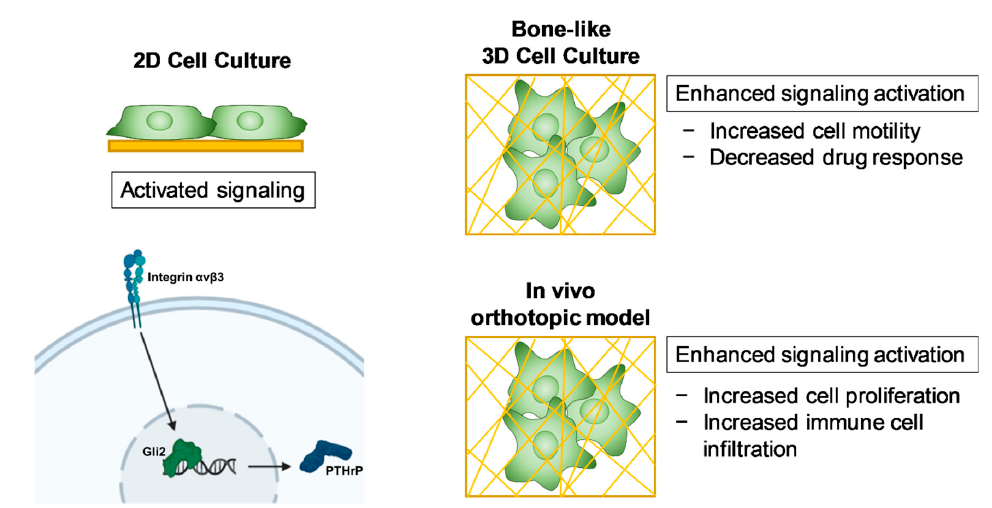
Figure 7. Schematic summary of the 3D bone-like culture system. Bone-like 3D culture of metastatic tumor cells increases signaling activation of genes associated with TIBD, increases cell motility, and influences immune cell infiltration in an in vivo orthotopic model.